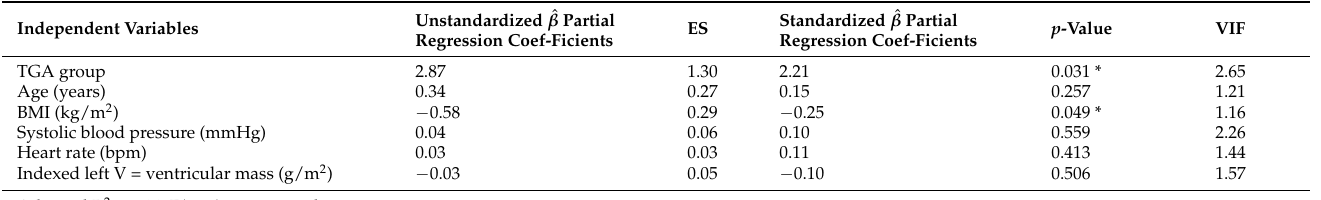
Table 4. Multivariable linear regression model for longitudinal strain measurements (LVpGLS) on overall sample ( n = 66).